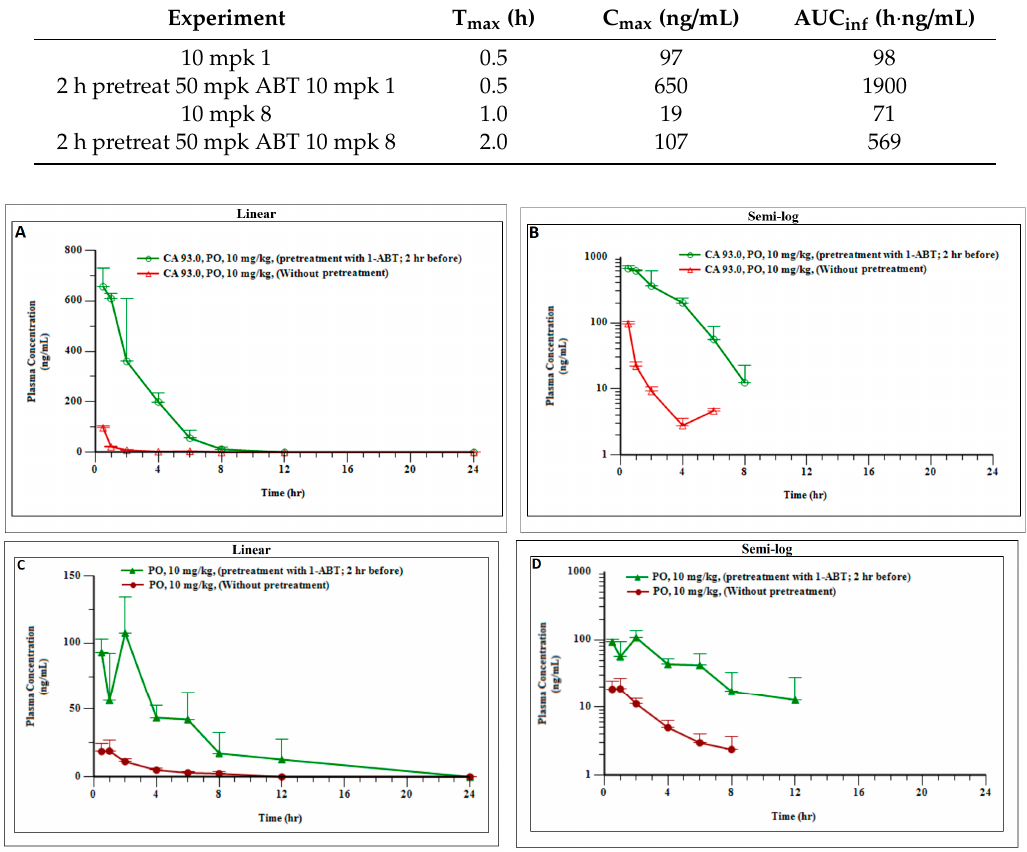
Figure 14. Plasma concentration profiles of 1 ( A, B ) and 8 ( C, D ) in mice (n = 18) following a 10 mg/kg po dose with (green) or without (red) 2 h pretreatment with 50 mg/kg ABT.